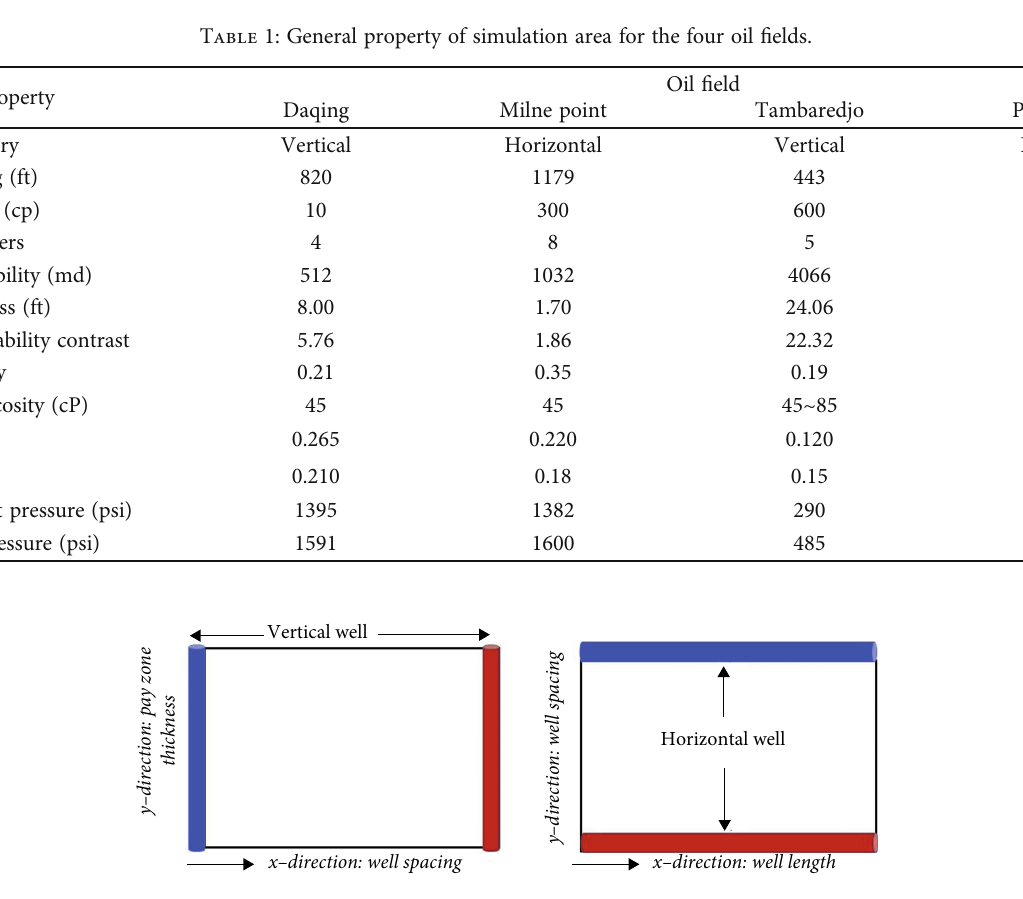
Figure 7: Illustration of polymer advancing direction in simulation